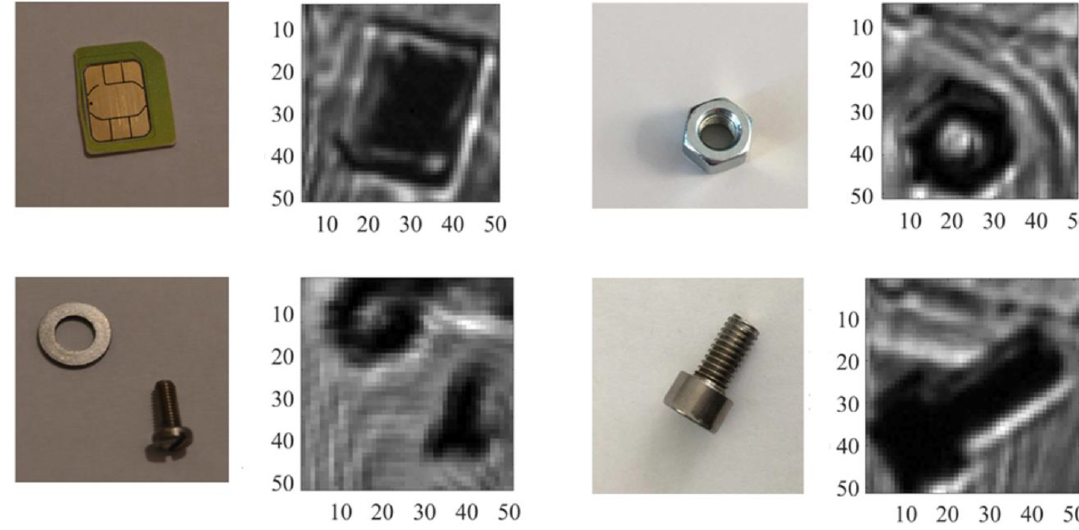
Figure 21. THz images of different metallic/plastic objects hidden inside a paper envelope acquired at 365 GHz (source modulation f = 130 Hz) along with the photographs of the